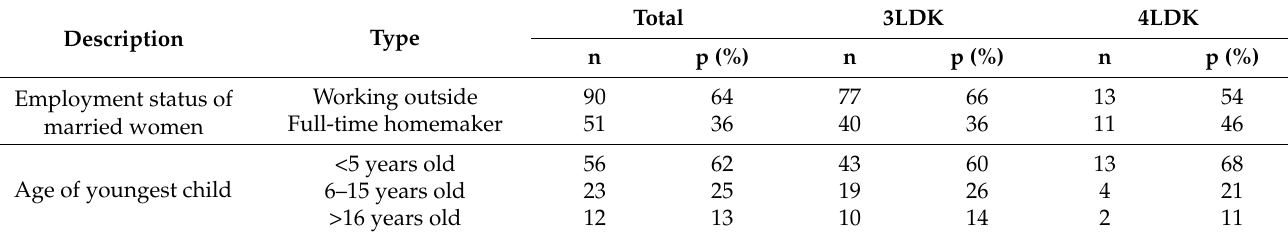
Table 5. Employment status of married women and age of children.